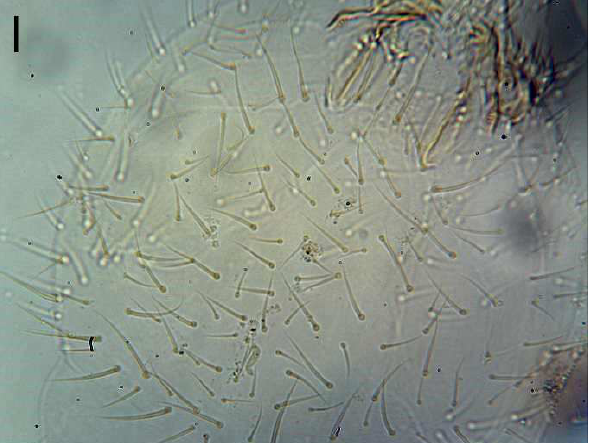
F IGURE 15. Head of Isotomiella without eye and PAO (scale: 100 µm)